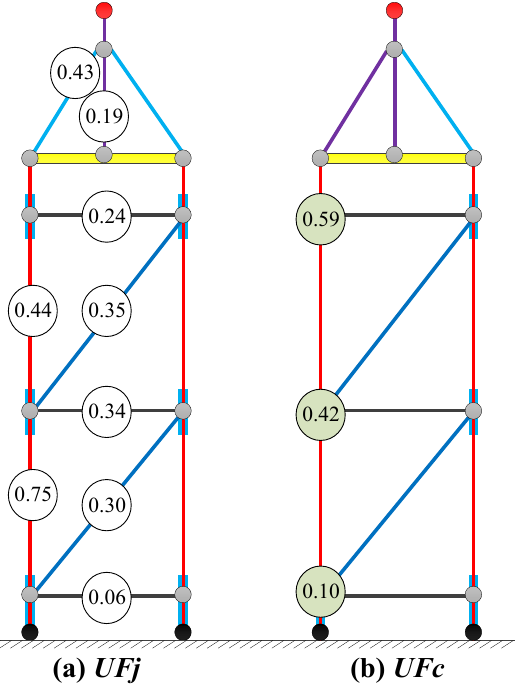
Figure 11. Results of strength check: ( a ) Jacket members; ( b ) Joint cans. In order to quantify how much the Env load effects contribute to the total responses of the jacket substructure, different comparisons are made in Figures 12 and 13. The analysis results of CB9 are utilized, since they produce the largest structural responses comparing to the other combined load cases. In Figures 12 and 13, the structural responses are normalized. This means the total (maximum) response of the jacket substructure under the condition of CB9 is defined as the scale of 100%.